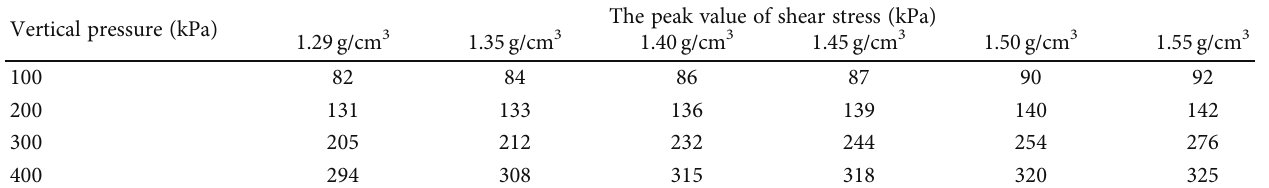
Table 6: The peak value of shear